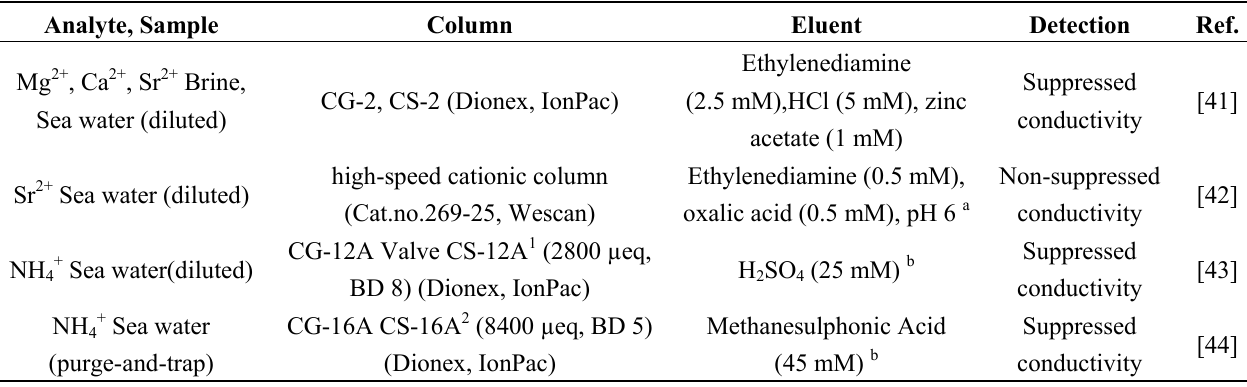
Table 4. Ion chromatographic determinations of concentrations of selected cations in waters with high ionic strength.